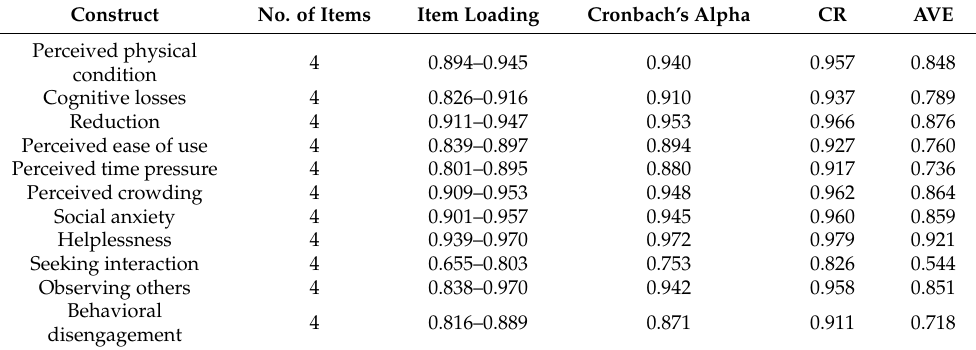
Table 2. Construct reliability.